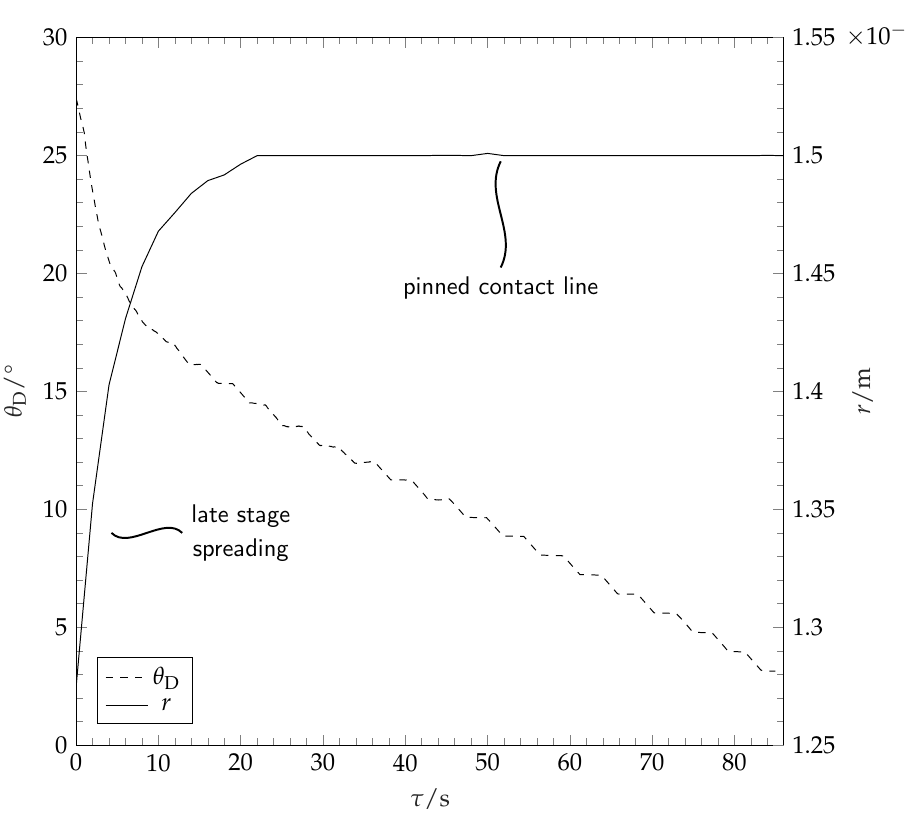
Figure 6. Contact angle (dashed line) and contact radius over time during late stage spreading and a large part of evaporation. Because of the low temporal resolution, the initial wetting stage as presented in Figure 3 cannot be observed. After approximately 10s, late stage wetting stops and the contact radius stays constant. The contact angle decreases linearly after the contact line is pinned. The last seconds of evaporation are excluded due to faulty image processing as the ridge formation interferes with contact angle determination. Toluene on PS ( M W = 335kgmol − 1